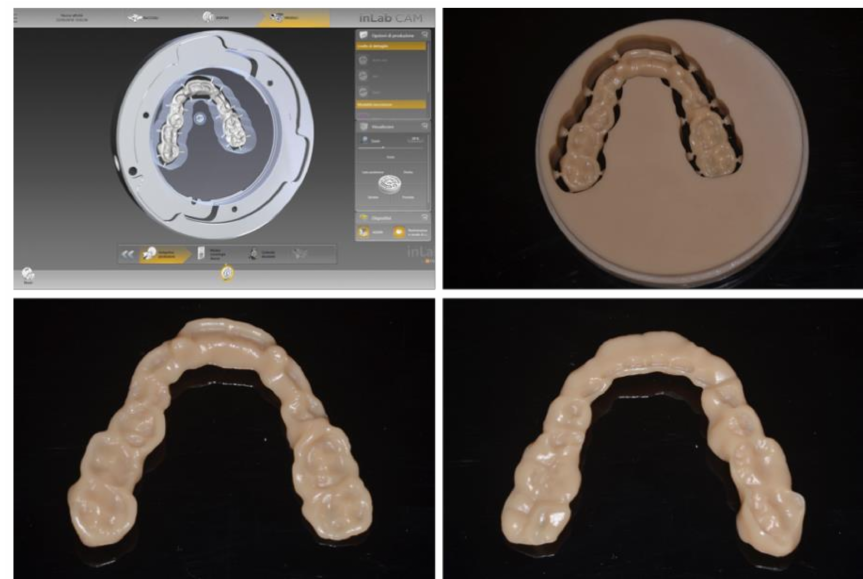
Figure 3. Prototypation (3D printing) of surgical splint.